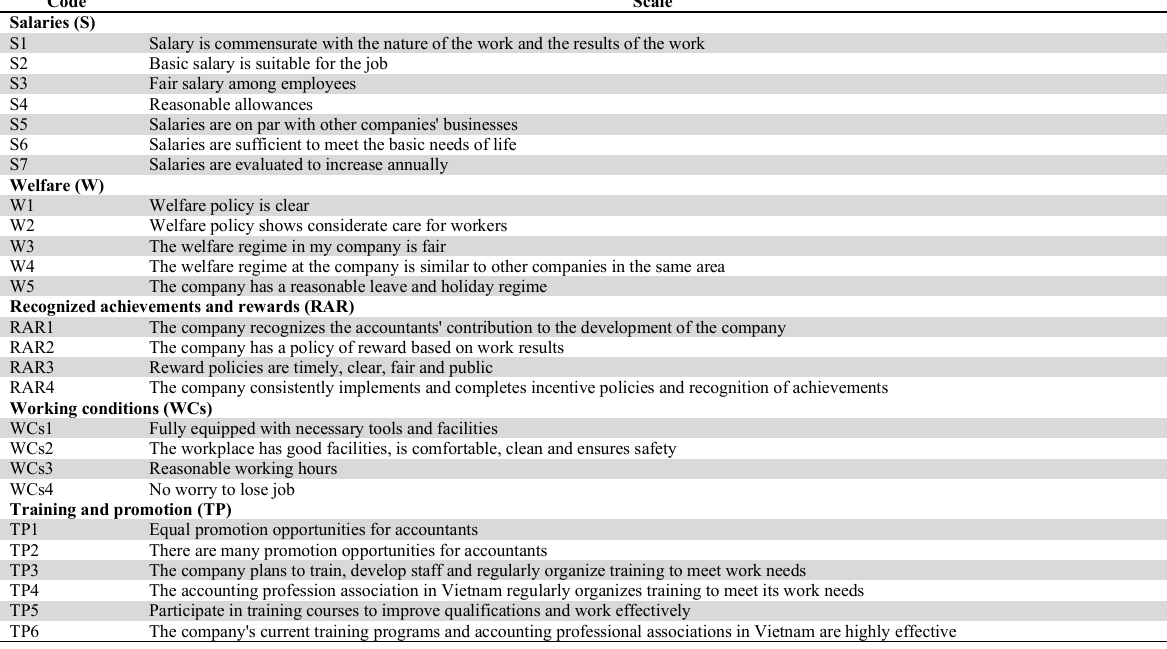
The attributes (indicators) of factors influencing on the job satisfaction amongst accountants Code Scale Salaries